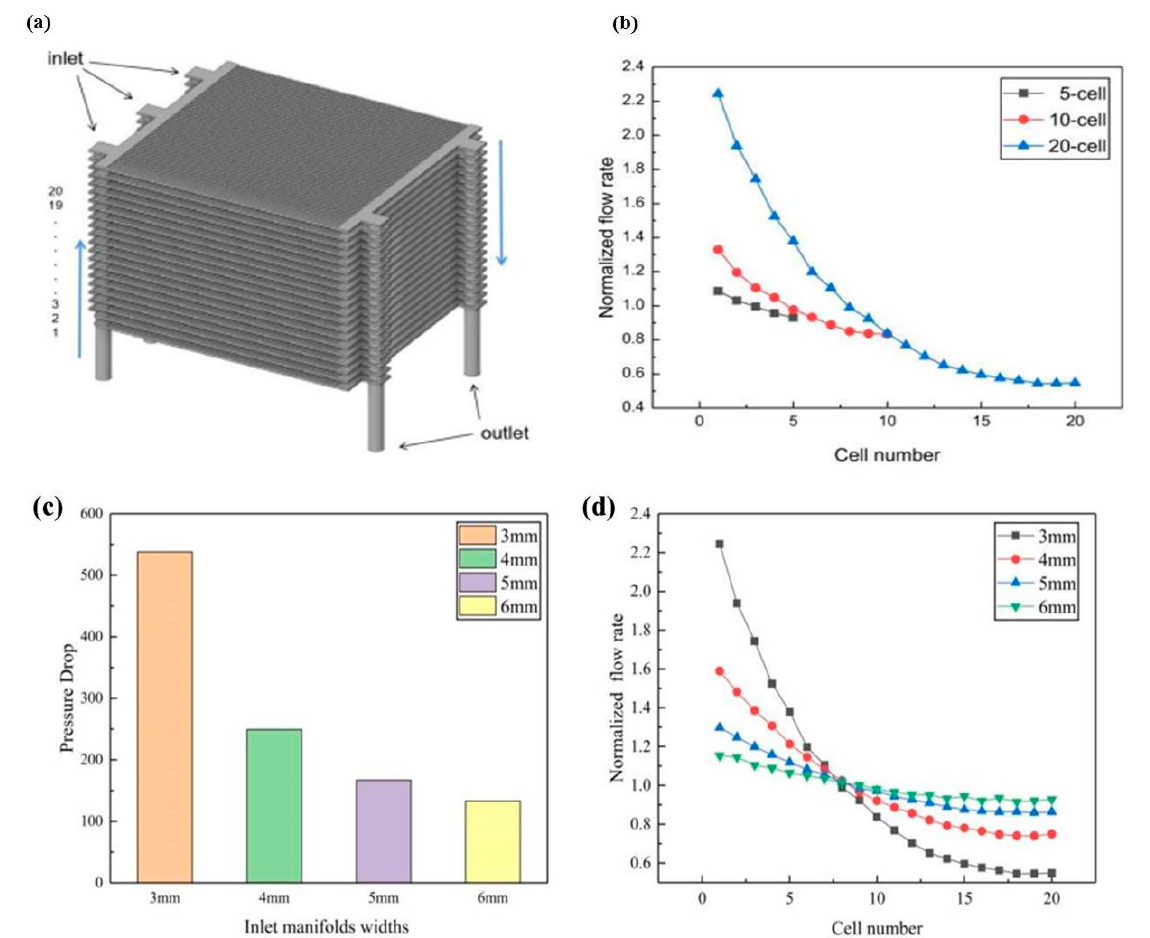
Figure 8. ( a ) 3D model of a 20 cells PCFC stack; ( b ) evaluation of flow distributions in 5, 10, and 20 cell PCFC stacks; ( c ) analysis of pressure drop vs. inlet manifolds width and ( d ) normalized flow rate versus cell numbers. Reproduced from the reference [37], open access.